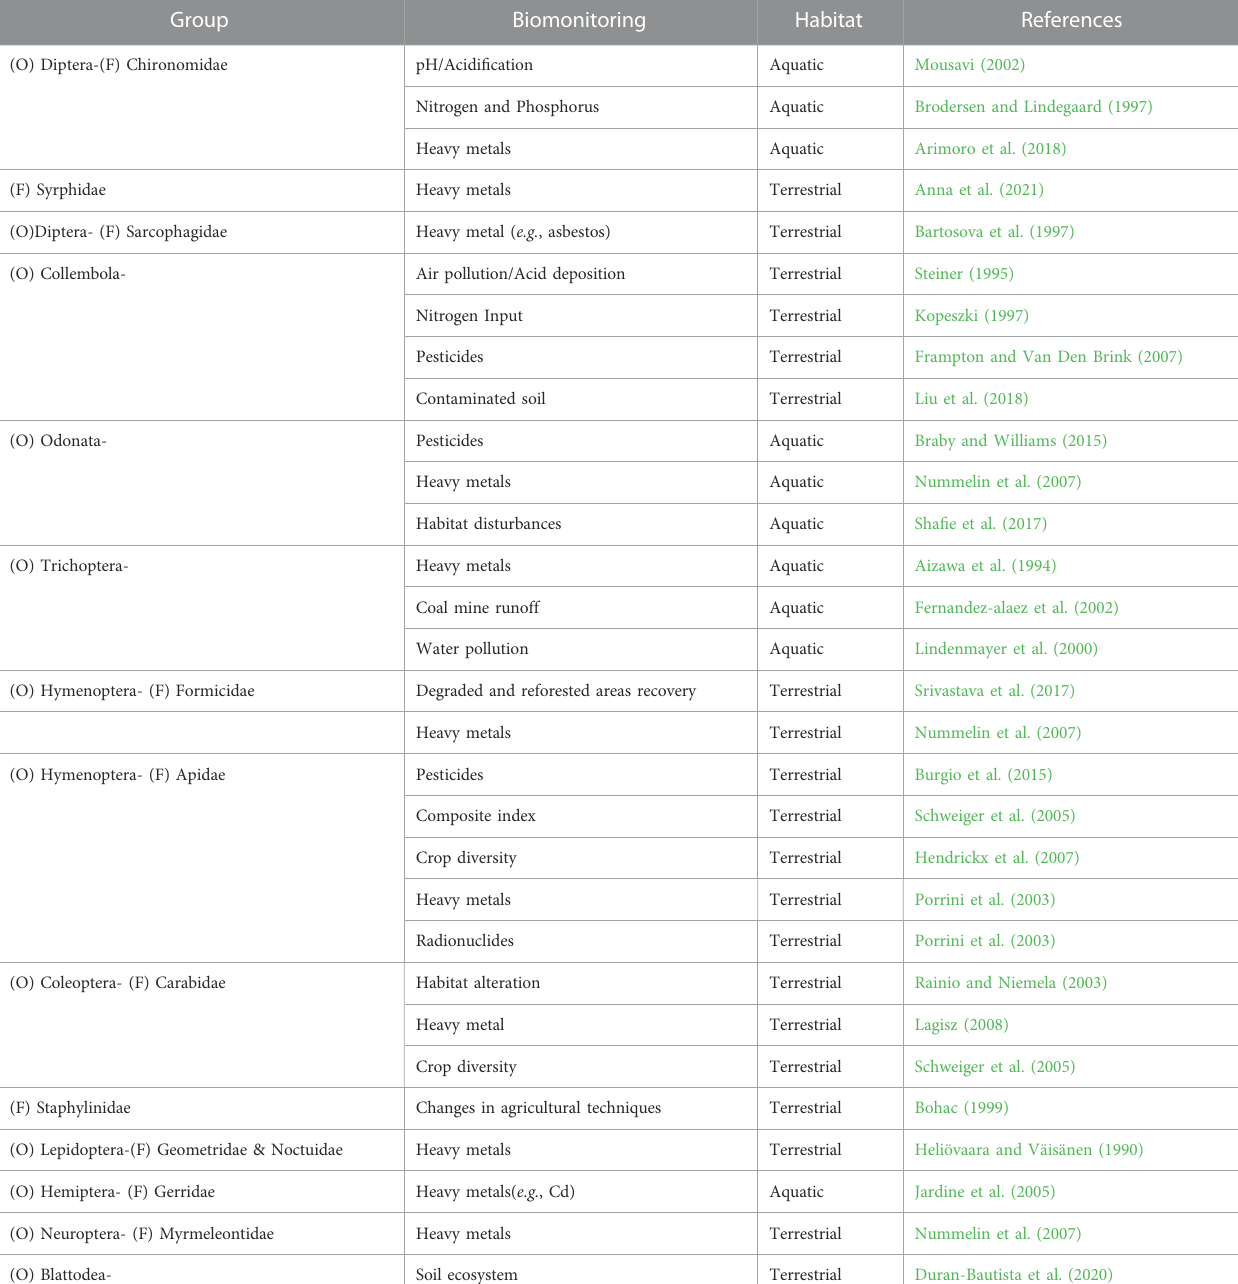
TABLE 1 Bioindicators for speci fi c variables in terrestrial and aquatic habitats.